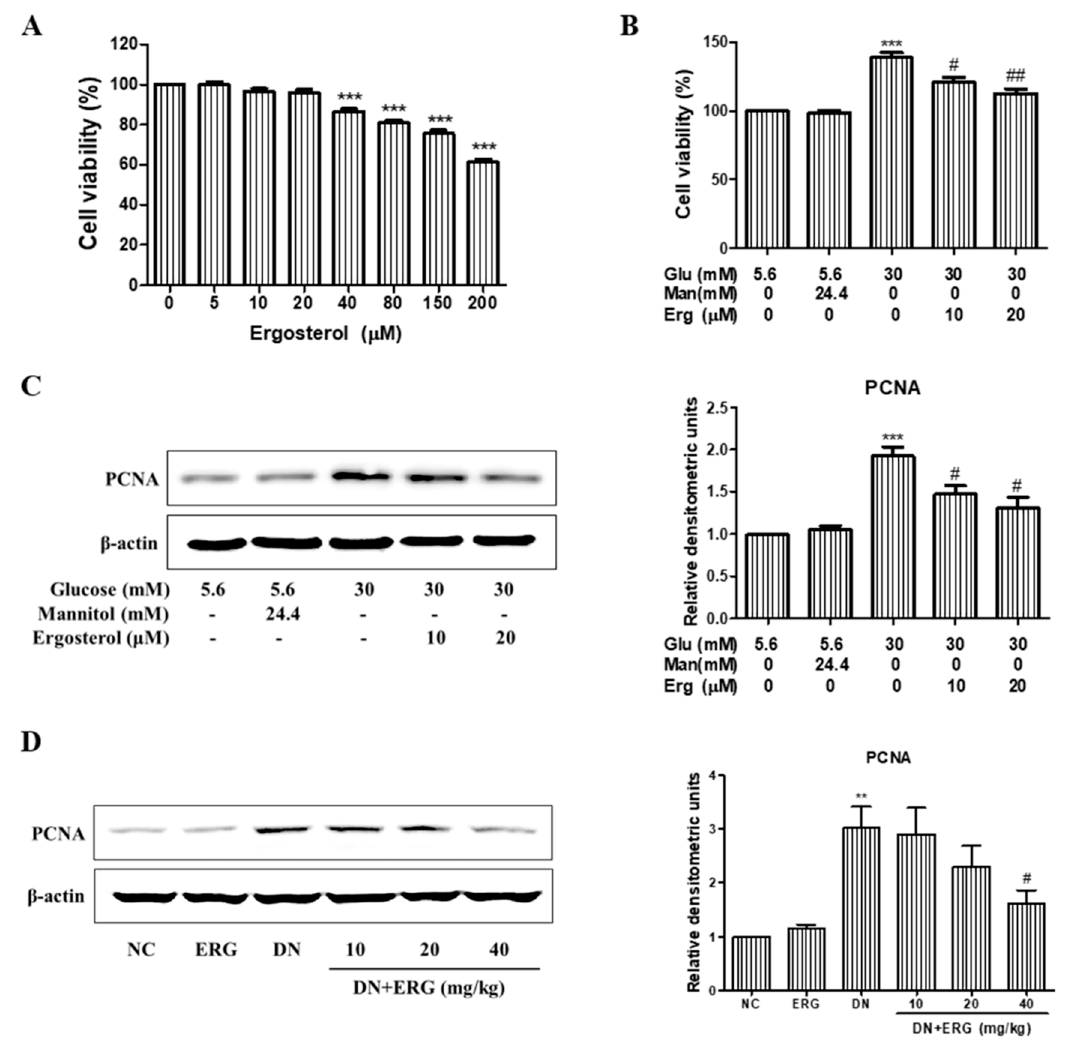
Figure 4. Ergosterol inhibited the proliferation of renal mesangial cells. ( A ) Rat glomerular mesangial cells (RMCs) were co-treated with and without ergosterol (10 or 20 μ M) under normal glucose conditions (5.6 mM glucose) for 48 h. Cell proliferation was measured by the 3-(4,5-dimetylthiazol-yl)-diphenyl tetrazolium bromide (MTT) assay. ( B ) RMCs were co-treated with and without ergosterol (10 or 20 μ M) under high glucose conditions (30 mM glucose) for 48 h. Cell proliferation was evaluated by the MTT assay. ( C , D ) Western blot analysis of proliferating cell nuclear antigen (PCNA) expression in cultured RMCs (Data are presented as the means ± SD, triplicate) and renal parenchyma (data are presented as the means ± SD, n = 3). NC: normal control; DN: diabetic nephropathy model induced by STZ; ERG: ergosterol administration. ** p <0.01, *** p <0.001 compared with normal glucose or normal control; # p <0.05, ## p <0.01 compared with high glucose or diabetic nephropathy model.